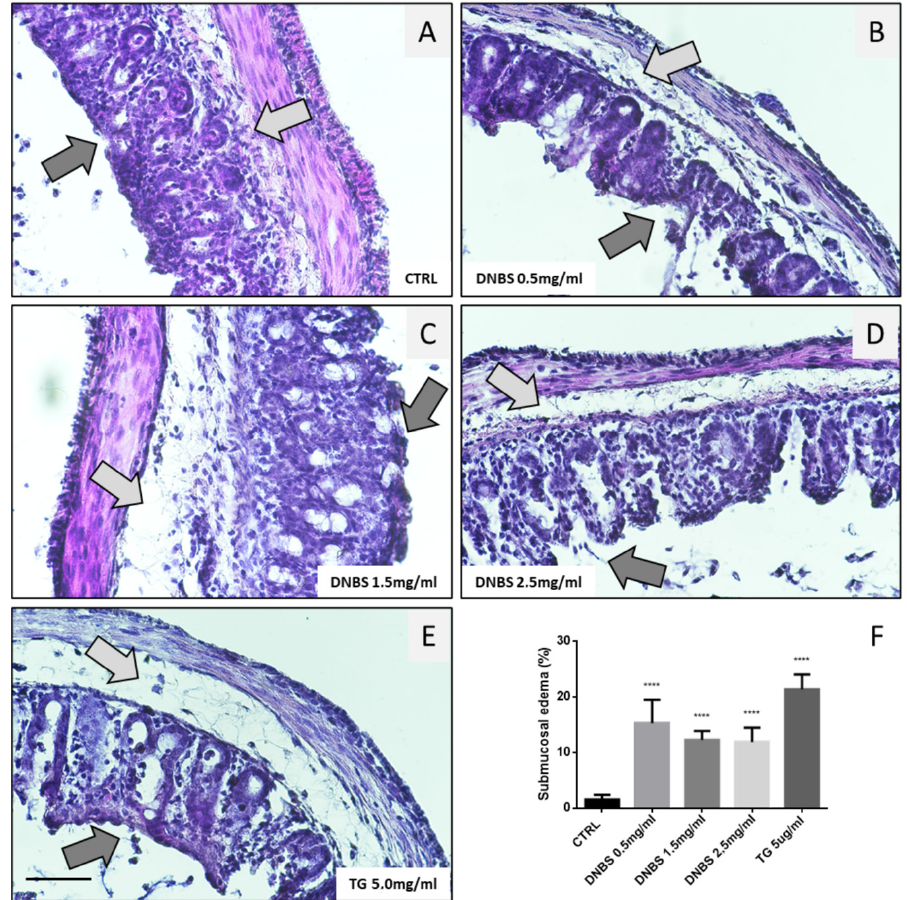
Figure 4. Altered morphology of colon treated with DNBS. Tissues (colon) were cultivated 5 h in the GEVS in absence (CTRL; A ) or presence of DNBS 0.5 ( B ), 1.5 ( C ), 2.5 mg/mL ( D ), or with TG 5 μ g/mL ( E ), and tissue morphology was evaluated in sections stained with H&E (magnification = 40×; bar = 100 μ m). Dark and light grey arrows indicate the luminal epithelia and the submucosa, respectively. ( F ) Submucosal edema was evaluated as a percentage of edema thickness relative to the thickness of the colon section. Histograms represent mean ± SD of about 10 measurements/experimental condition; **** p < 0.0001.